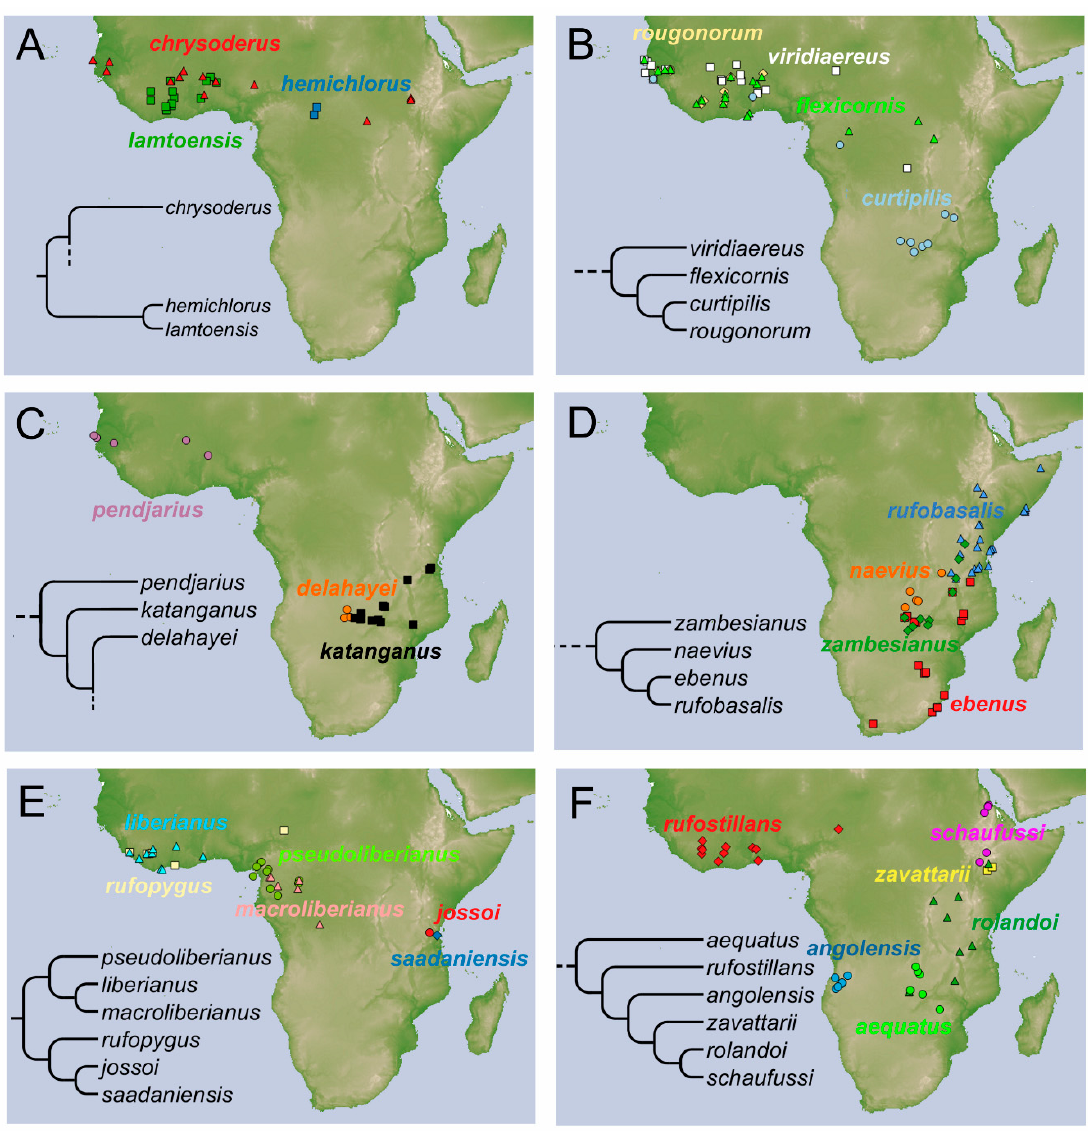
Figure 7. Distribution maps of Tiaronthophagus species, highlighting the phylogenetic relationships among them (see Figure 3 for complete tree). ( A ): T. chrysoderus (red), T. hemichlorus (blue) and T. lamtoensis (green). ( B ): T. rougonorum (yellow), T. viridiaereus (white), T. flexicornis (green) and T. curtipilis (blue). ( C ): T. pendjarius (violet), T. delahayei (orange) and T. katanganus (black). ( D ): T. rufobasalis (blue), T. naevius (orange), T. zambesianus (green) and T. ebenus (red). ( E ): T. liberianus (turquoise), T. rufopygus (yellow), T. pseudoliberianus (green), T. macroliberianus (rose), T. jossoi (red) and T. saadaniensis (blue). ( F ): T. rufostillans (red), T. schaufussi (violet), T. zavattari (yellow), T. rolandoi (dark green), T. angolensis (blue), T. aequatus (light green). Tiaronthophagus angolensis n.sp.